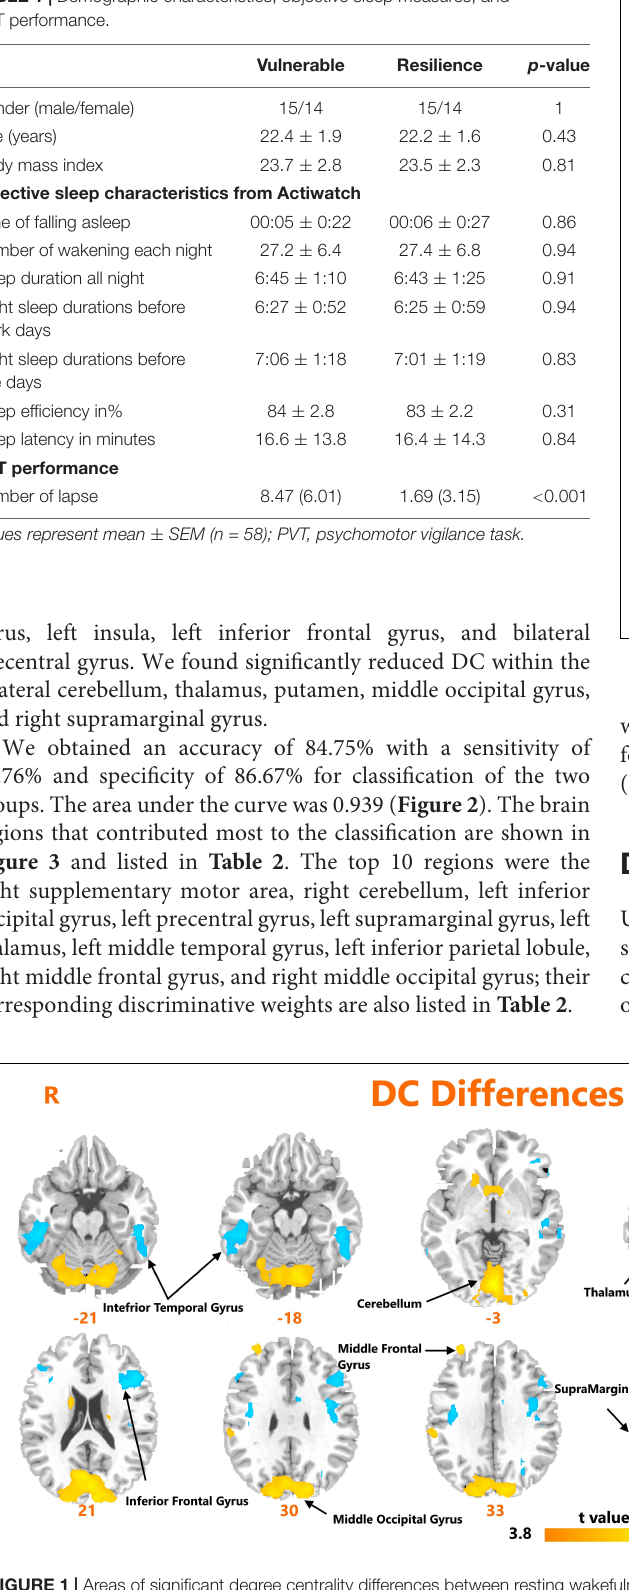
Frontiers in Neuroscience |